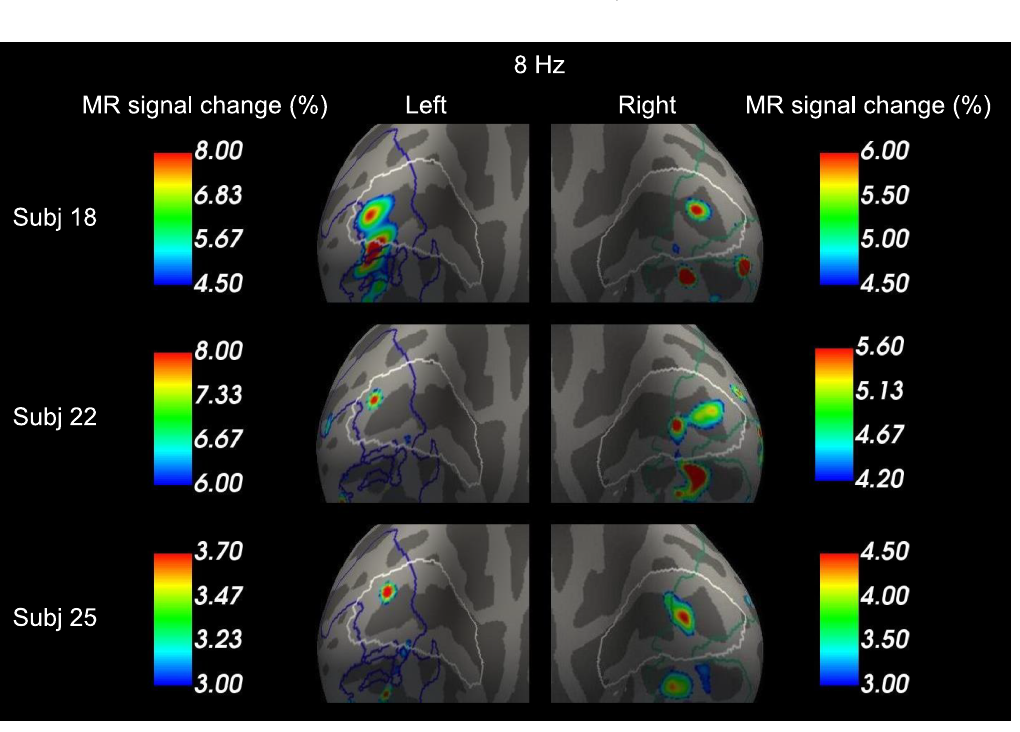
Fig 4. Individual peak responses to 8 Hz are within the V1 region in which the brain activity of 8 Hz was higher than that of 2 Hz in the group analysis. Peak brain responses to 8 Hz among the three representative subjects in Fig 1 are overlaid on the group analysis results of 8 Hz > 2 Hz contrast in Fig 3C. Blue and green lines on the brain surfaces indicate the border of the 8 Hz > 2 Hz region. White lines on the brain surfaces indicate the border of V1.